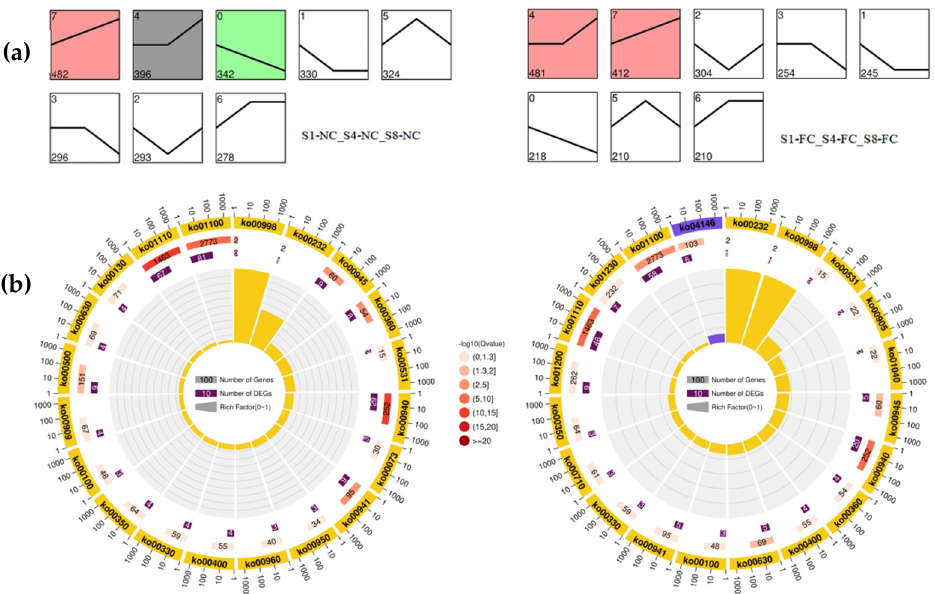
Figure 4. ( a ) Trend analysis of DEGs divided into eight clusters based on expression patterns. Profiles are ordered based on the number of genes assigned; ( b ) KO enrichment circle diagram. Outermost circle: the top 20 enriched pathways with the number of genes shown outside the circle. Different colours represent different classes. Second circle: the number of pathways and the Q values in the background gene. Longer bars represent a higher number of genes, while the smaller the Q value, the redder the colour; Third circle: the number of differentially expressed genes in the pathway. Fourth circle: the RichFactor value of each pathway (the number of differentially expressed genes in the pathway divided by the total number of genes), where each grid represents 0.1.